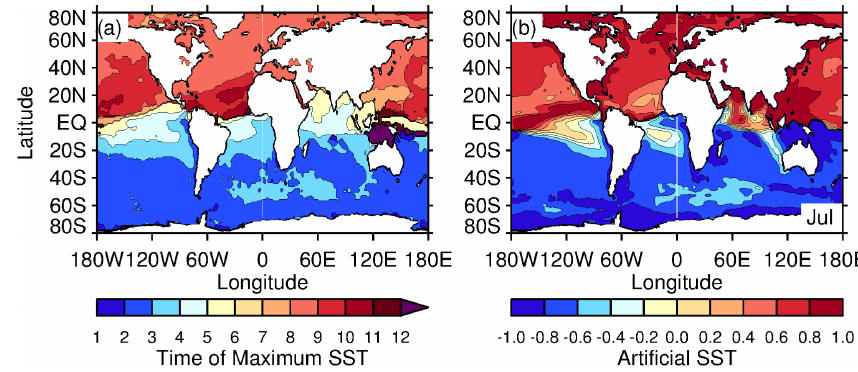
Figure A3. Visualization of the artificial SST generated from the annual cycle component of a fit to real SST data (for details see text). Panel (a) shows the calendar month when the annual cycle takes its maximum, panel (b) shows, for the example of July, the global distribution reconstructed from the annual cycle. Since the amplitude is normalized to 1 everywhere, panel (b) closely matches the structures of panel (a) ; the distribution for January is the inverse of panel (b)